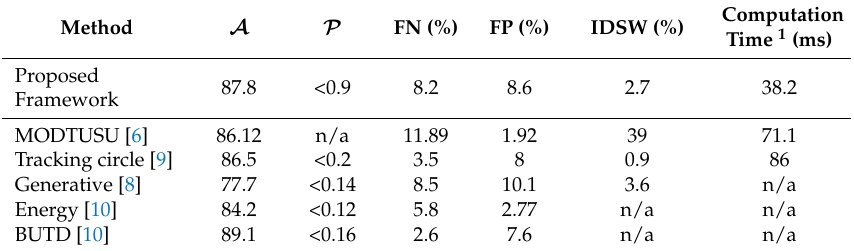
Table 3. Comparison of tracking evaluation metrics and computation